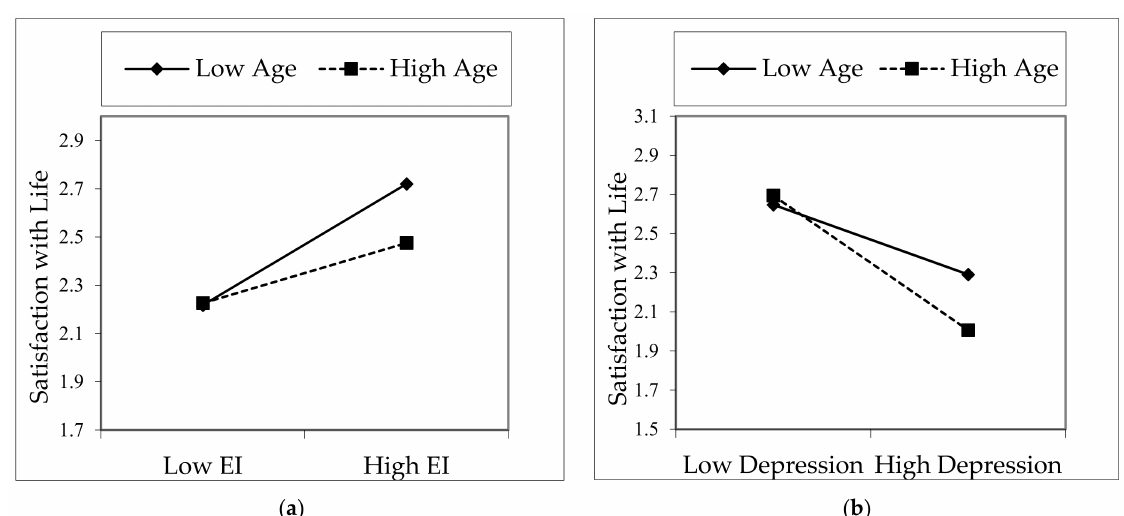
Figure 2. Interaction effect of age and EI ( a ) and age and depression ( b ) on satisfaction with